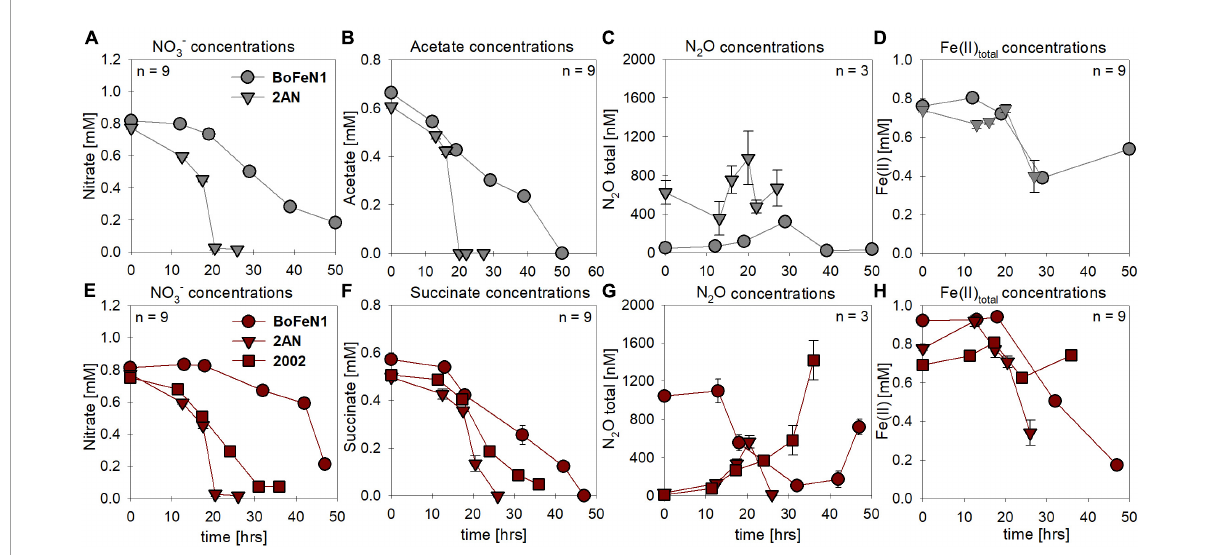
FIGURE2 Concentrations for nitrate (A,E) and organic acids [acetate (gray), succinate (red)] consumed (B,F) , N 2 O produced (C,G) and Fe(II) oxidized (D,H) during mixotrophic growth in strains of Acidovorax sp. strain BoFeN1, Acidovorax delafieldii strain 2AN and “ Pseudogulbenkiania ferrooxidans” strain 2002. No growth was observed for the control denitrifier Paracoccus denitrificans strain ATCC 19367, as well as for strain 2002 on acetate. Standard error calculated from biological replicates ( n = 9, 3) is represented by the error bars.